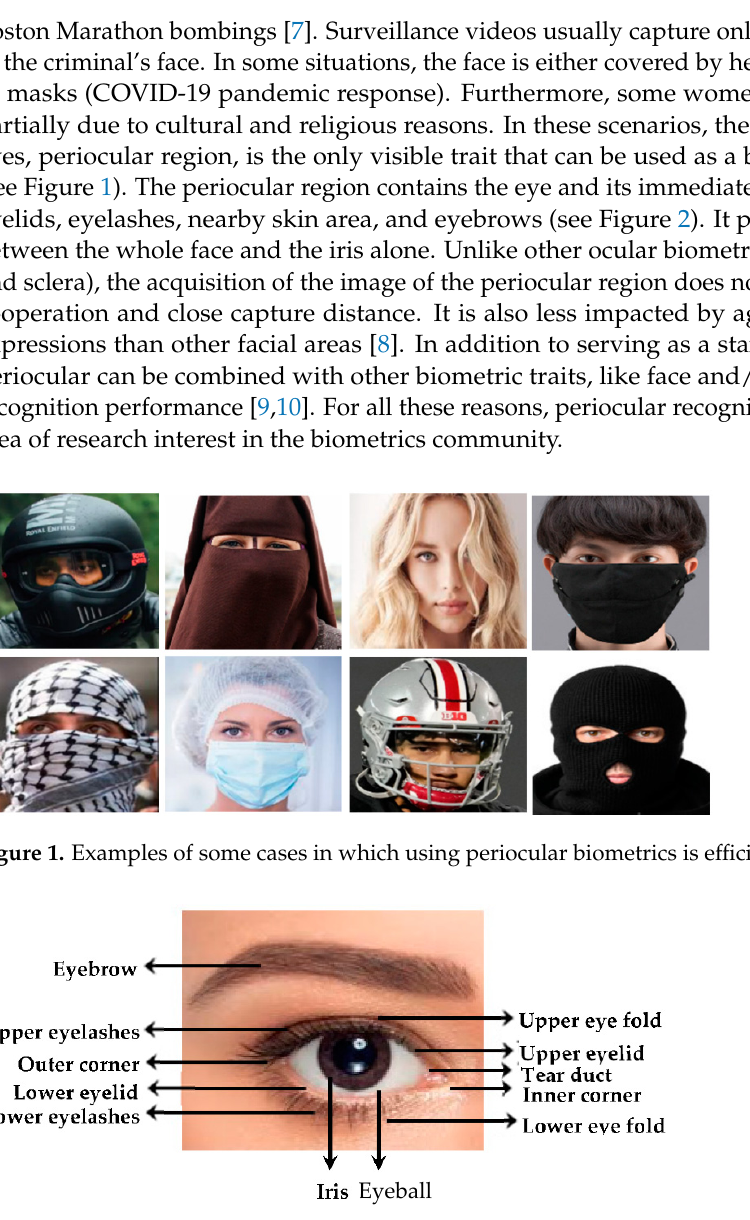
Figure 2. Periocular region and its elements.